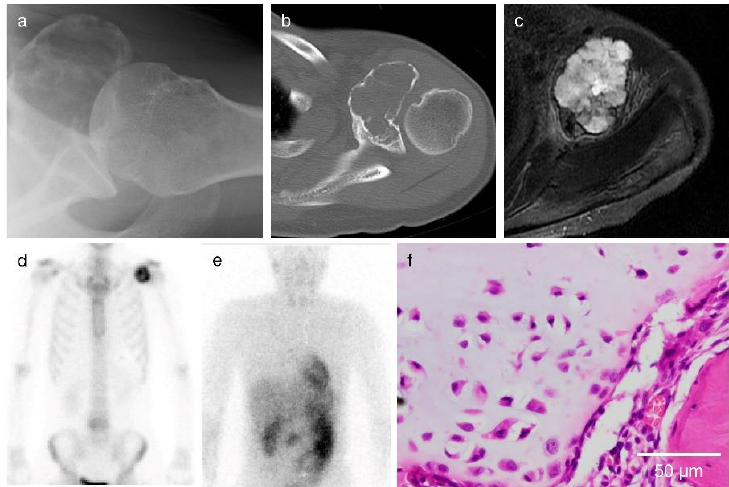
Figure 4. Case 2. A 48-year-old woman presenting shoulder pain. ( a ) The radiograph showed no periosteal reaction. ( b ) CT showed endosteal scalloping and cortical defect. ( c ) MRI showed multilobular lesion, whereas no extraskeletal mass and abnormal signal in adjacent tissue was seen. ( d ) Bone scan showed increased uptake greater than the anterior iliac crest. ( e ) 201 Tl scan showed no increased uptake in the proximal humerus. Based on the findings, the overall radiological score rate was calculated as follows: [0 points (X-ray) + 3 points (CT) + 3 points (MRI) + 2 points (bone scan) + 0 points ( 201 Tl scan)]/16 points (full marks) = 50.0%. ( f ) The microscopic image showed moderate cellularity, with cells embedded in hyaline matrix. A closed chromatin pattern and inconspicuous nucleoli were shown. The final histological diagnosis was grade I chondrosarcoma.